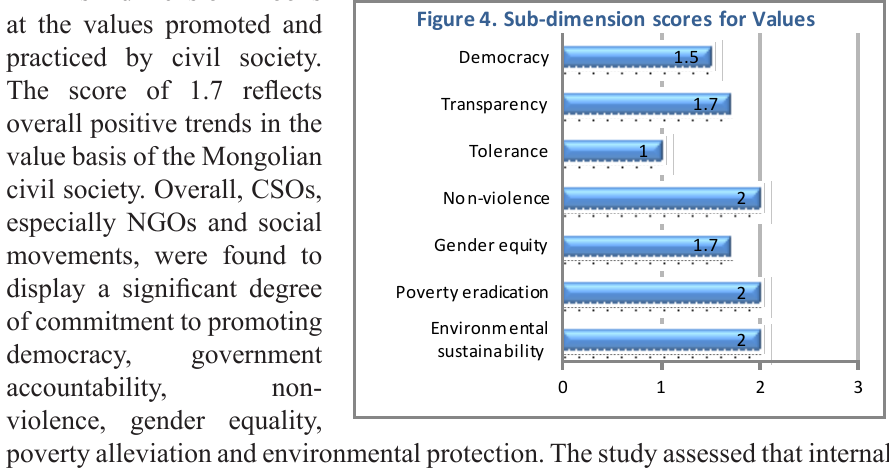
Figure 4. Sub-dimension scores for